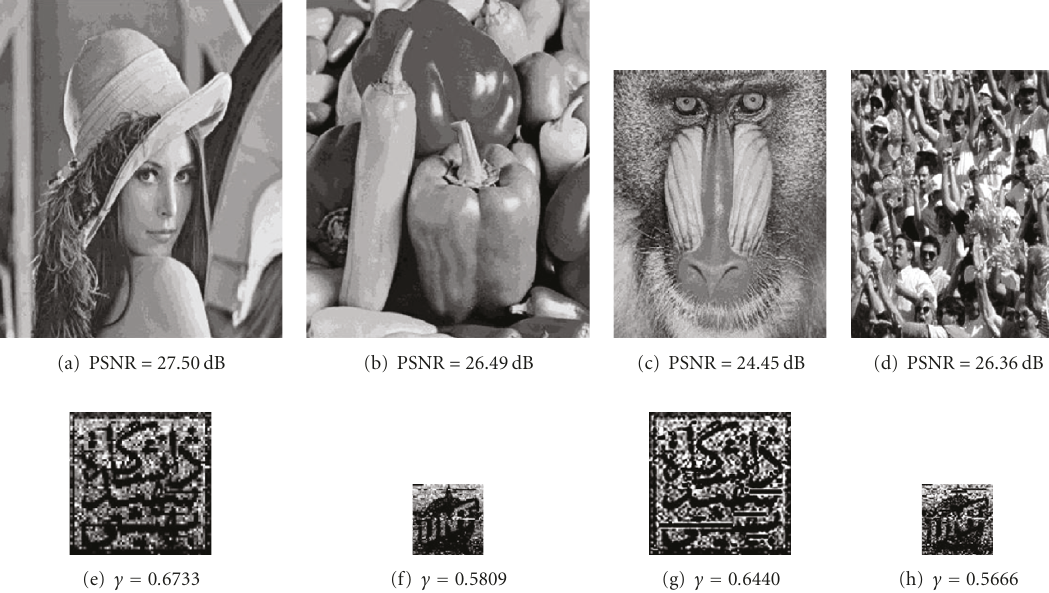
Figure 26: (a) and (b) The watermarked Lena and Peppers images after changing aspect ratio attack ( X = 1, Y = 1 . 2), respectively. (c) and (d) the watermarked Baboon and Crowd images after changing aspect ratio attack ( X = 0 . 8, Y = 1), respectively. (e)–(h) The extracted watermarks from (a)–(d),